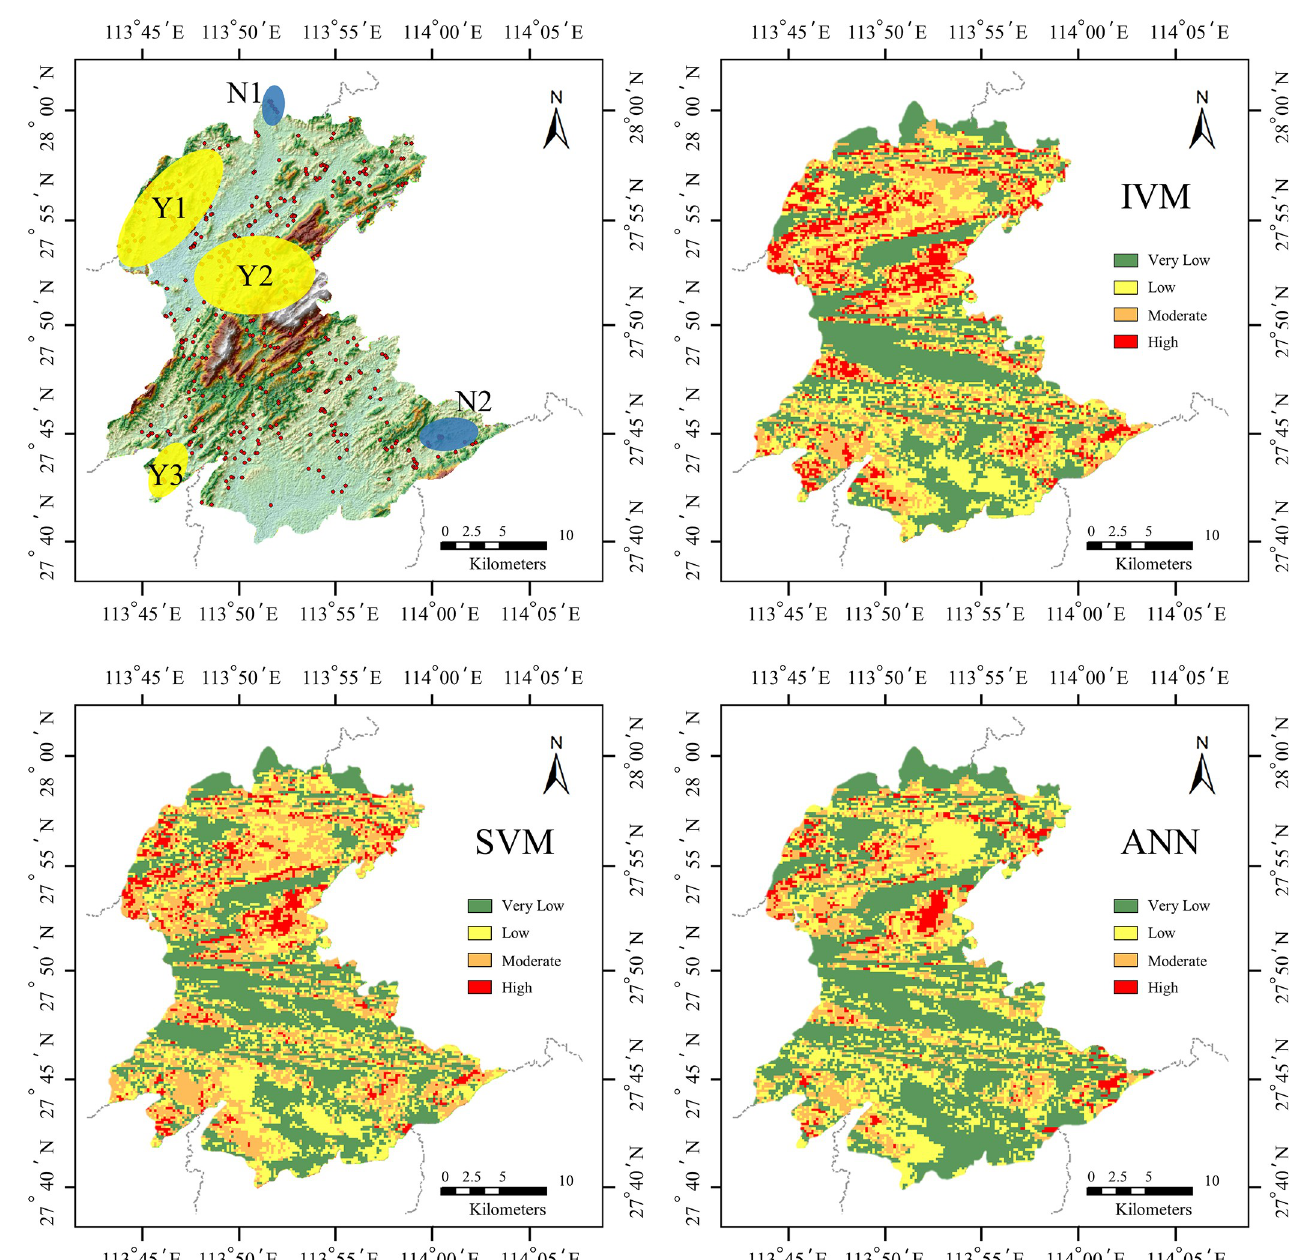
Fig 8. Comparison of actual distribution of landslides with three estimated models. reference model. The closer the RPS is to 0, the better the classification result. A positive RPSS value indicates that the forecast model is superior to the reference forecast. Form the results, it can be found that ANN has a lower RPS value than SVM which indicates that the classification results of ANN have a smaller range of uncertainty and are more reliable. Compare to the val- ues of RPSS, the ANN model and SVM model are both perform better than reference model, and ANN model is superior to the SVM model and original model.